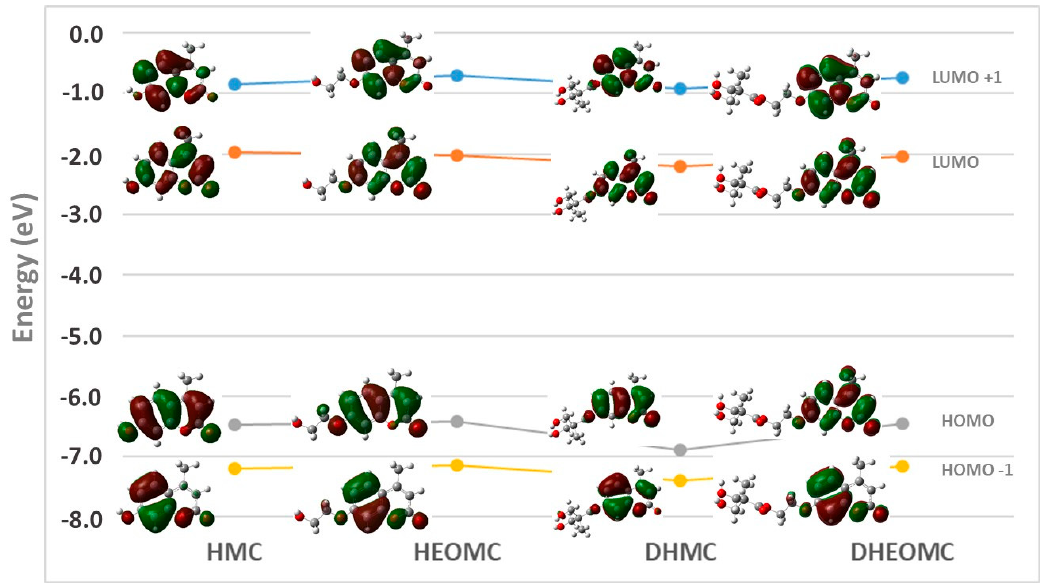
Figure 7. Distribution and schematic representation of the frontier orbitals of the coumarins studied.